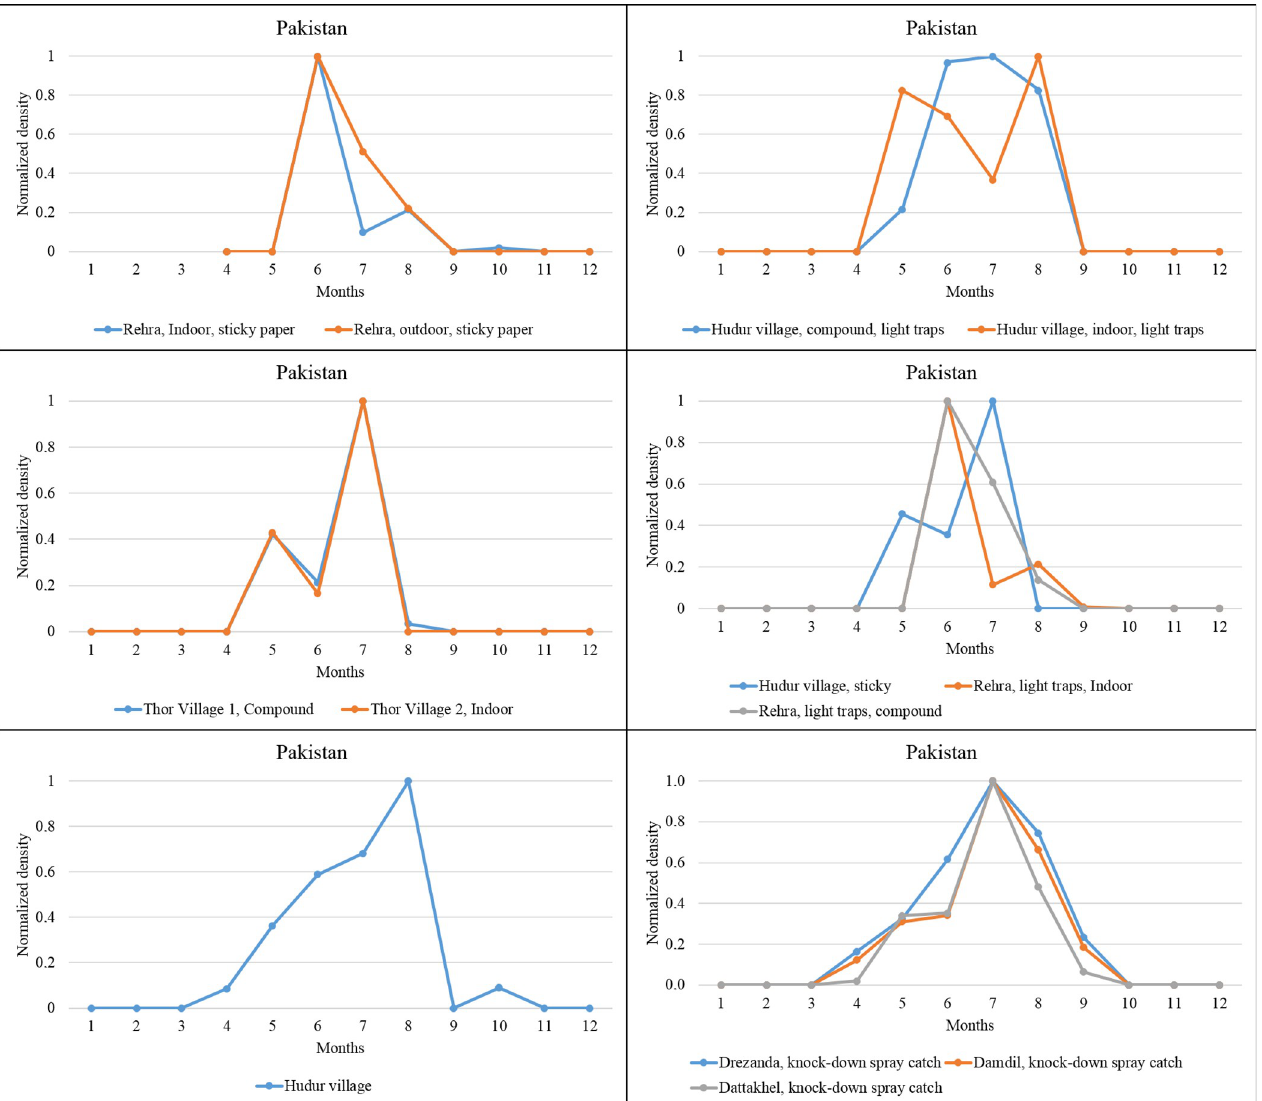
Fig 7. The seasonal P . (Par . ) sergenti density (normalized values) extracted for southern Asia countries. Sites from the same locality were gathered in a single graph.